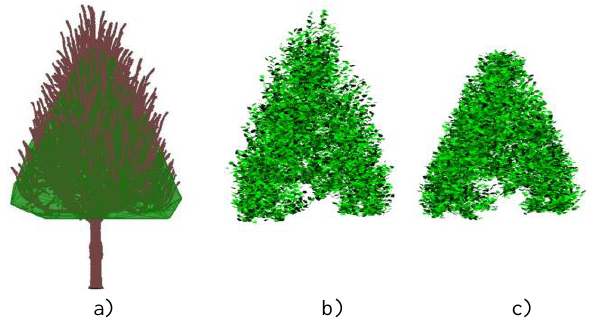
Figure 9. Substraction of models for June foliage creation (a); results of 3D reconstructed foliage of October (b) and June (c)